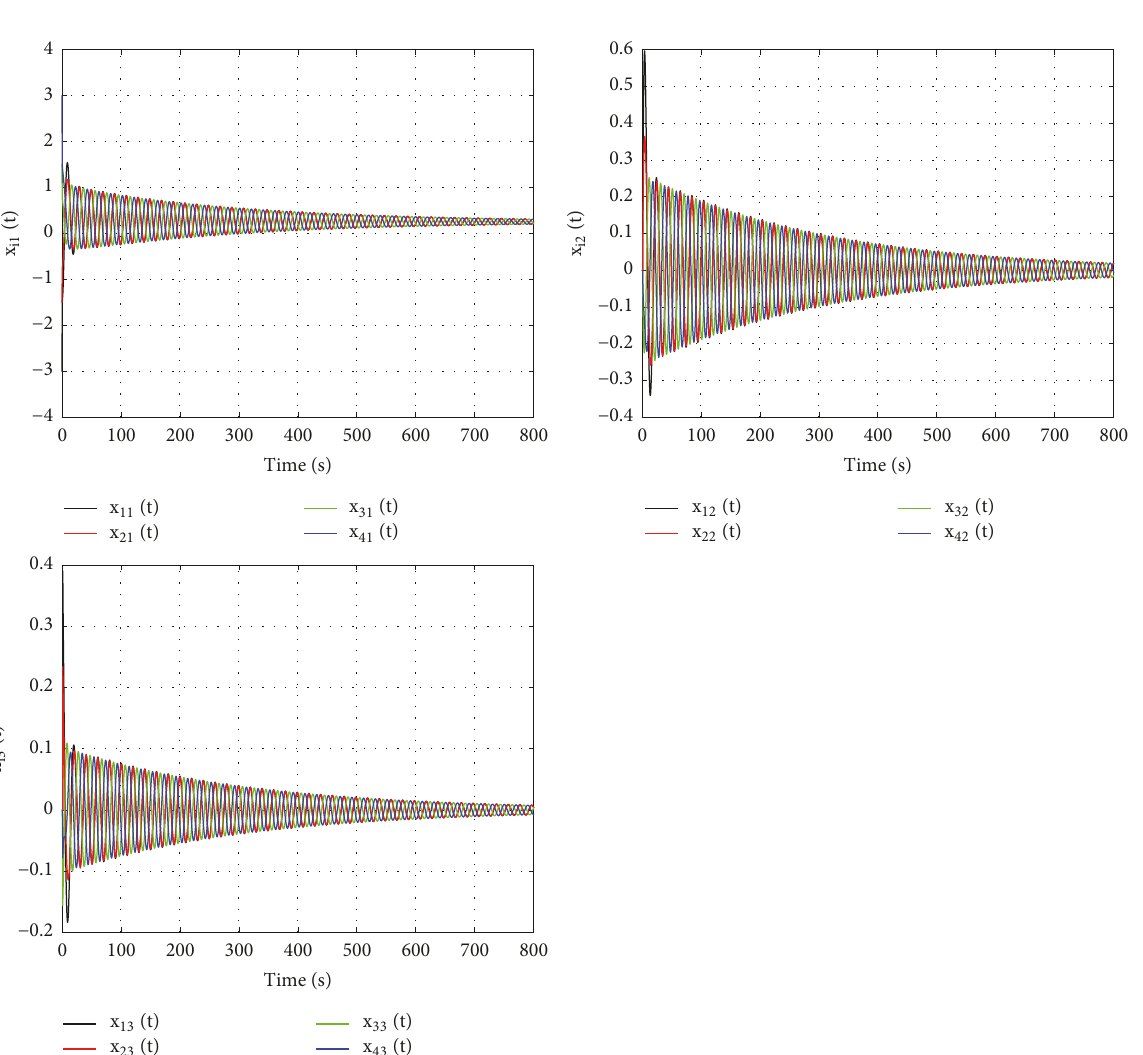
delay margin 𝜏 , which indicates that consensus of the FOMAS with double integral and asymmetric time-delays can not be